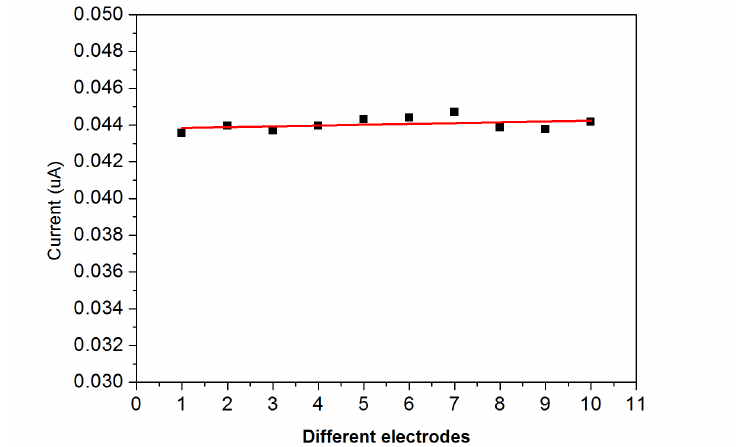
Figure 3. Reproducibility of the disposable